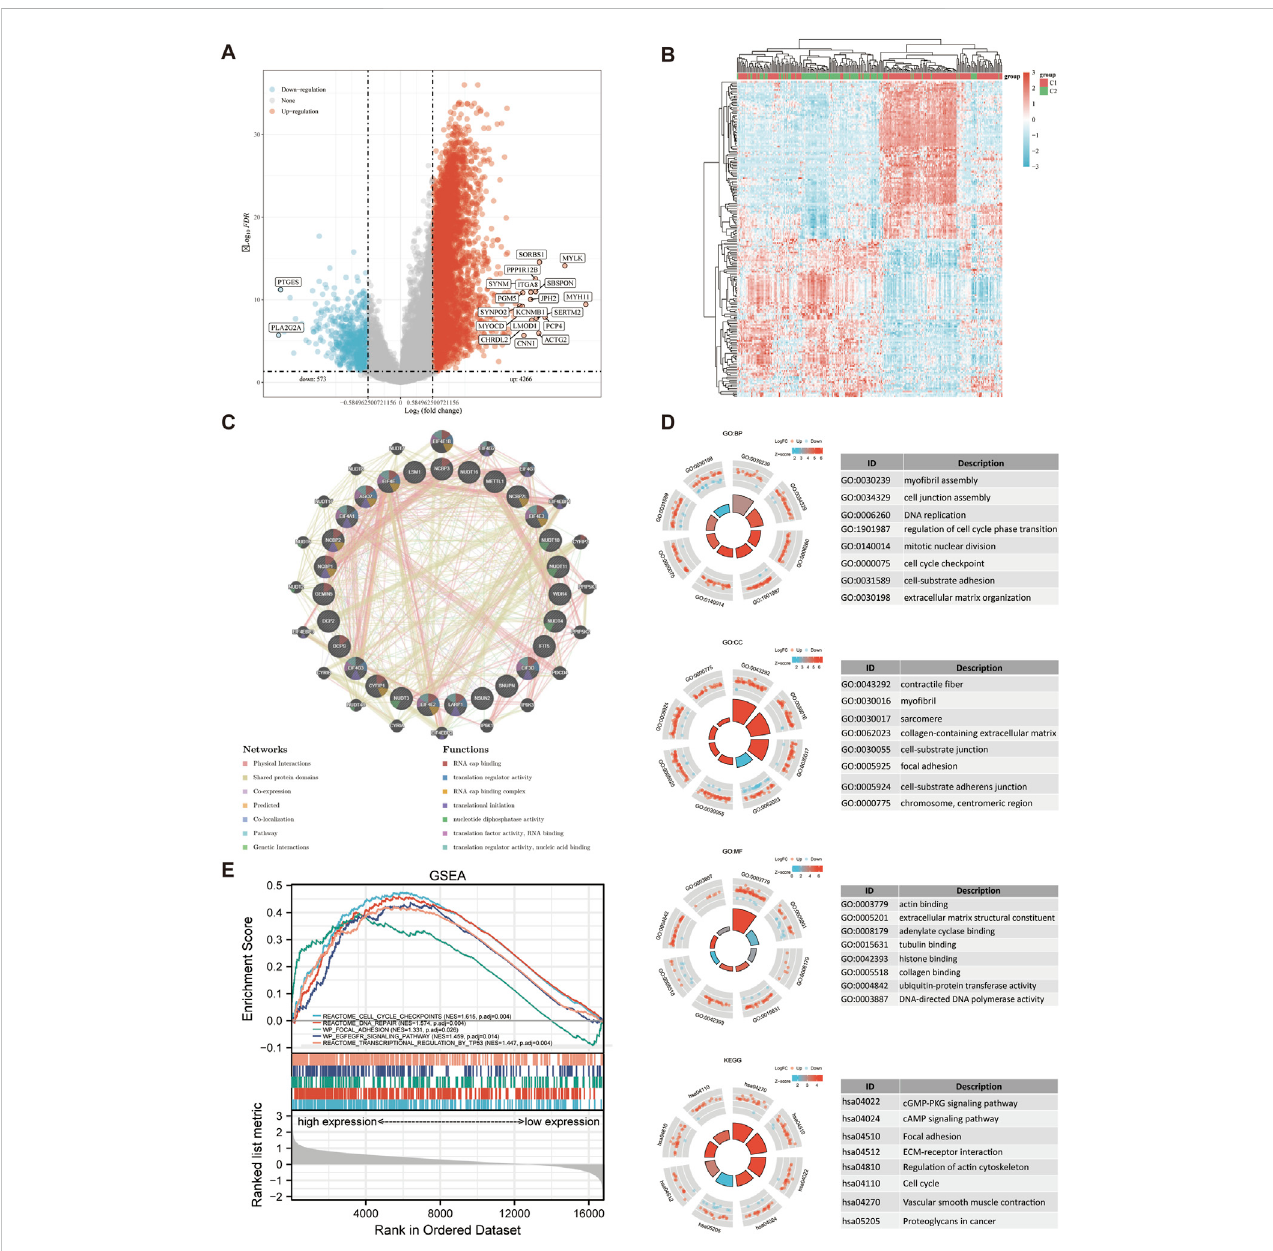
FIGURE 4 DEGs and functional enrichment analysis. (A) DEGs ’ volcano plot between C1 and C2 subtypes. (B) DEGs ’ heat map between C1 and C2 subtypes. (C) Gene Interaction Network. (D) Enriched item in GO analysis and KEGG analysis. (E) Enrichment plots from GSEA. BP, biological process; CC, cellular composition; MF, molecular